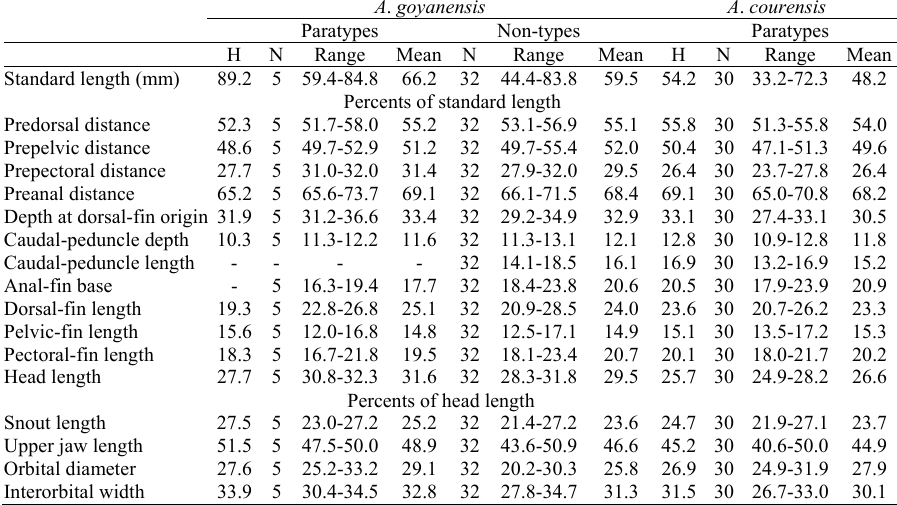
Table 1. Morphometric data of holotype (H), paratypes, and non-types of Astyanax goyanensis , and holotype and paratypes of Astyanax courensis , new species, from the rio dos Couros basin, upper rio Tocantins basin, Alto Paraíso de Goiás, Goiás State, Brazil. The range of paratypes and non-types of A . goyanensis not includes the holotype, but of A . courensis